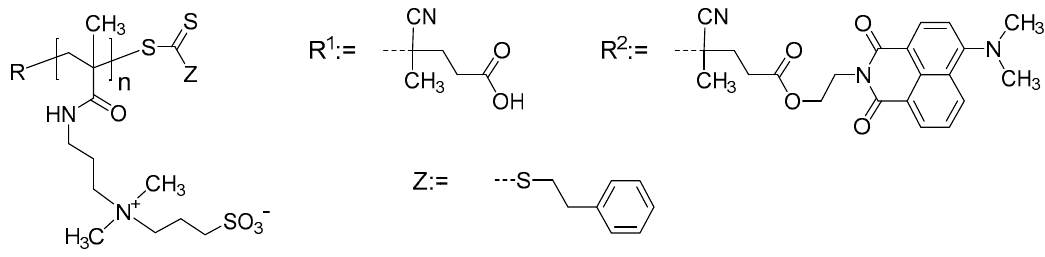
Figure 1. Chemical structure of the polyzwitterions under investigation, PSPP n [18]. R 2 serves as label for future UV-Vis spectroscopy. For R 1 , the degree of polymerization is n = 80, while for R 2 , n = 85 and 280.